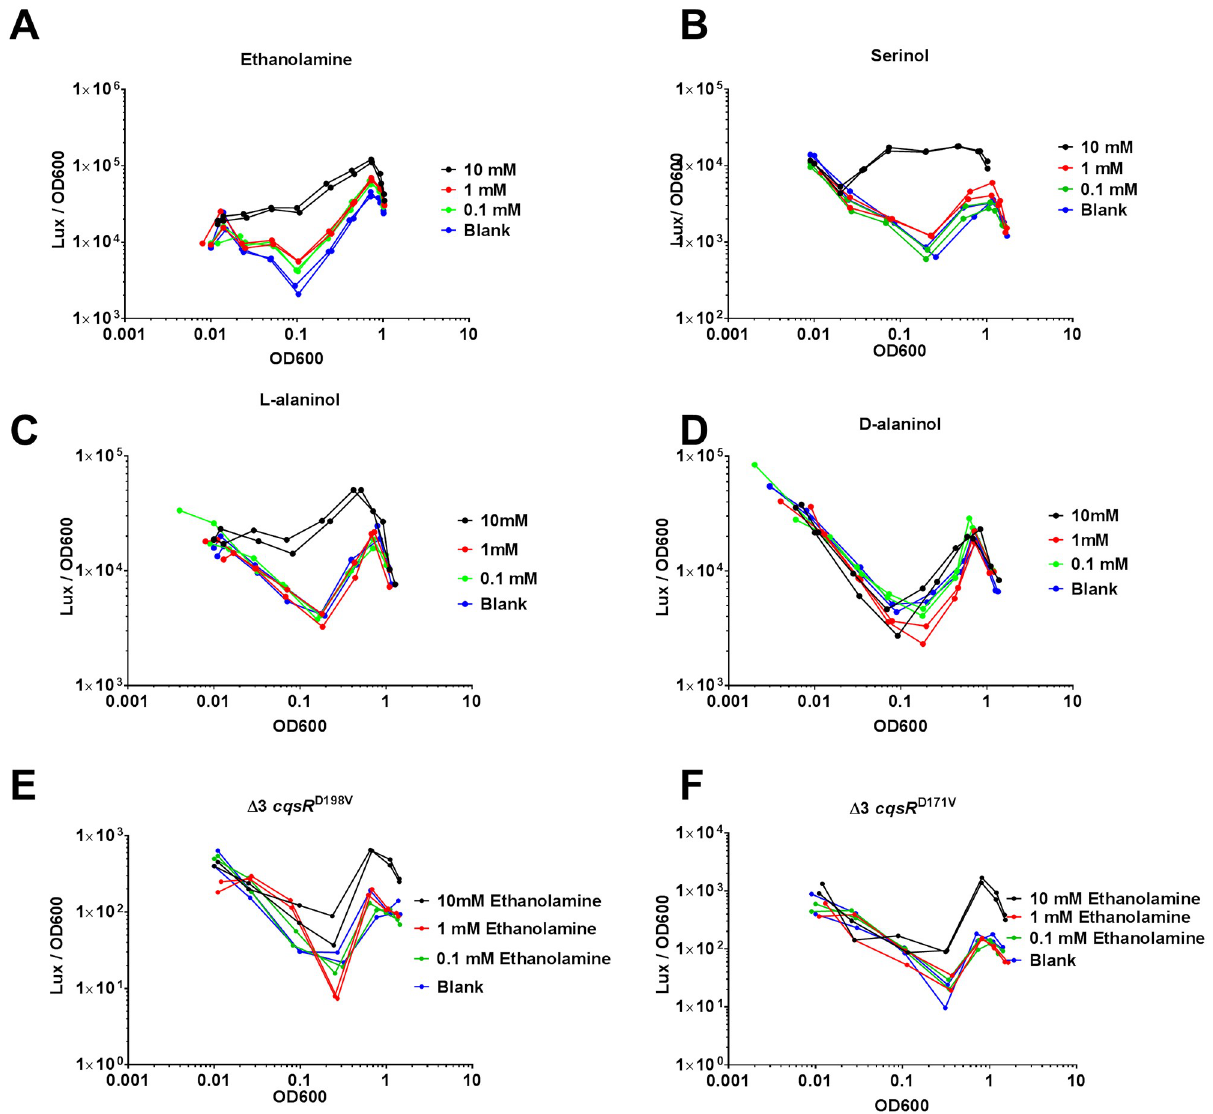
Fig 5. Effects of ethanolamine and its analogs on CqsR quorum-sensing response. HapR-dependent bioluminescence profiles (lux/OD 600 ) were measured in a Δ 3 cqsR + strain in the presence of 10 mM, 1mM, 0.1 mM A) ethanolamine, B) serinol, C) L-alaninol, D) D-alaninol. Blank indicates LB medium without ethanolamine added. HapR-dependent bioluminescence profiles (lux/OD 600 ) were measured in E) Δ 3 cqsR D198V strain and F) Δ 3 cqsR D171V strain in the presence of 10 mM, 1mM, 0.1 mM concentrations ethanolamine respectively. Each figure shows a representative profile of each condition with two biological replicates. Each experiment was performed independently at least two times.